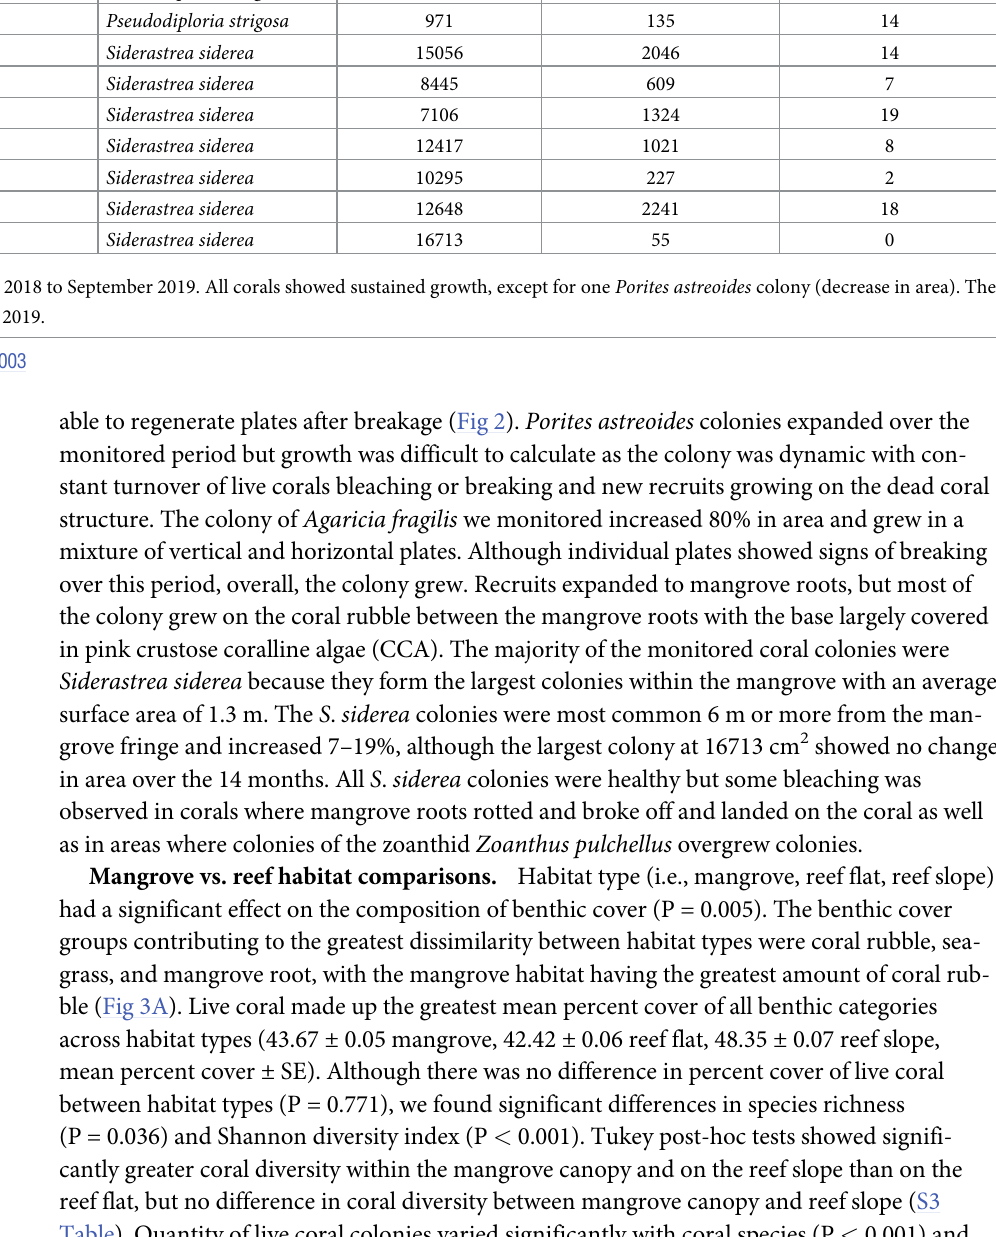
Table 3. Mangrove canopy coral colony